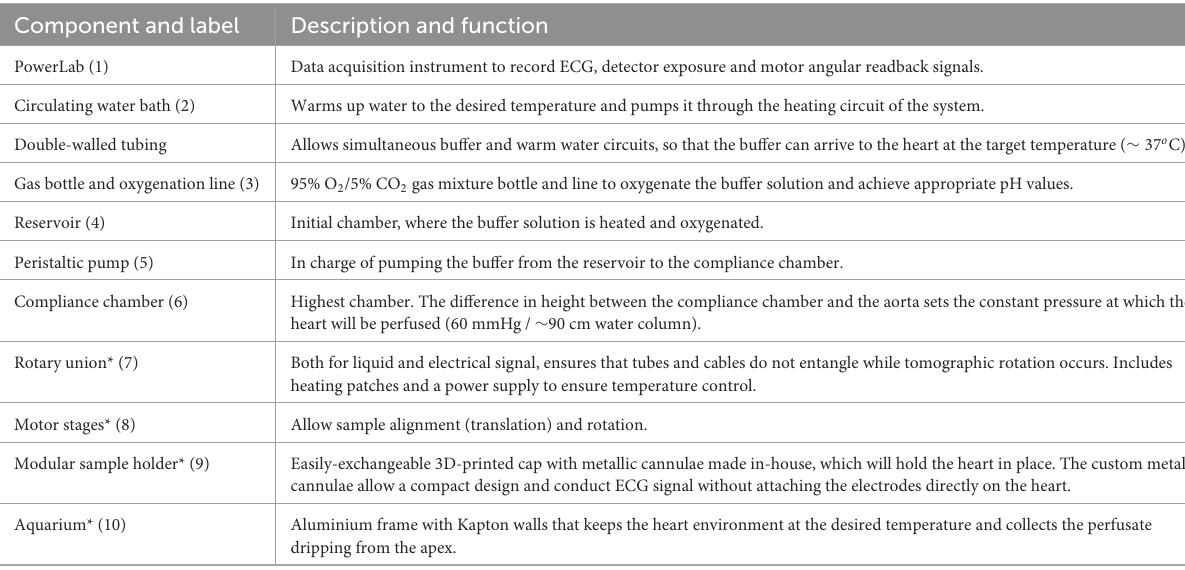
TABLE 1 Description and function of the hardware components of the tomographic microscopy-compatible Langendorff system, labeled with respect to Figure 1. Component and label Description and function